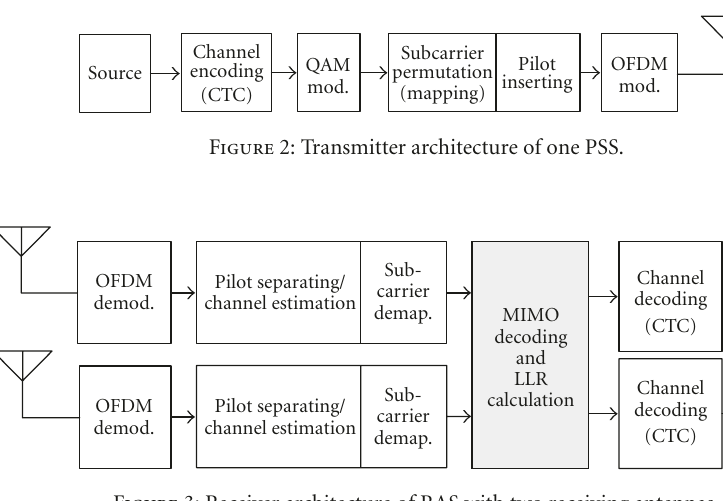
Figure 3: Receiver architecture of RAS with two receiving